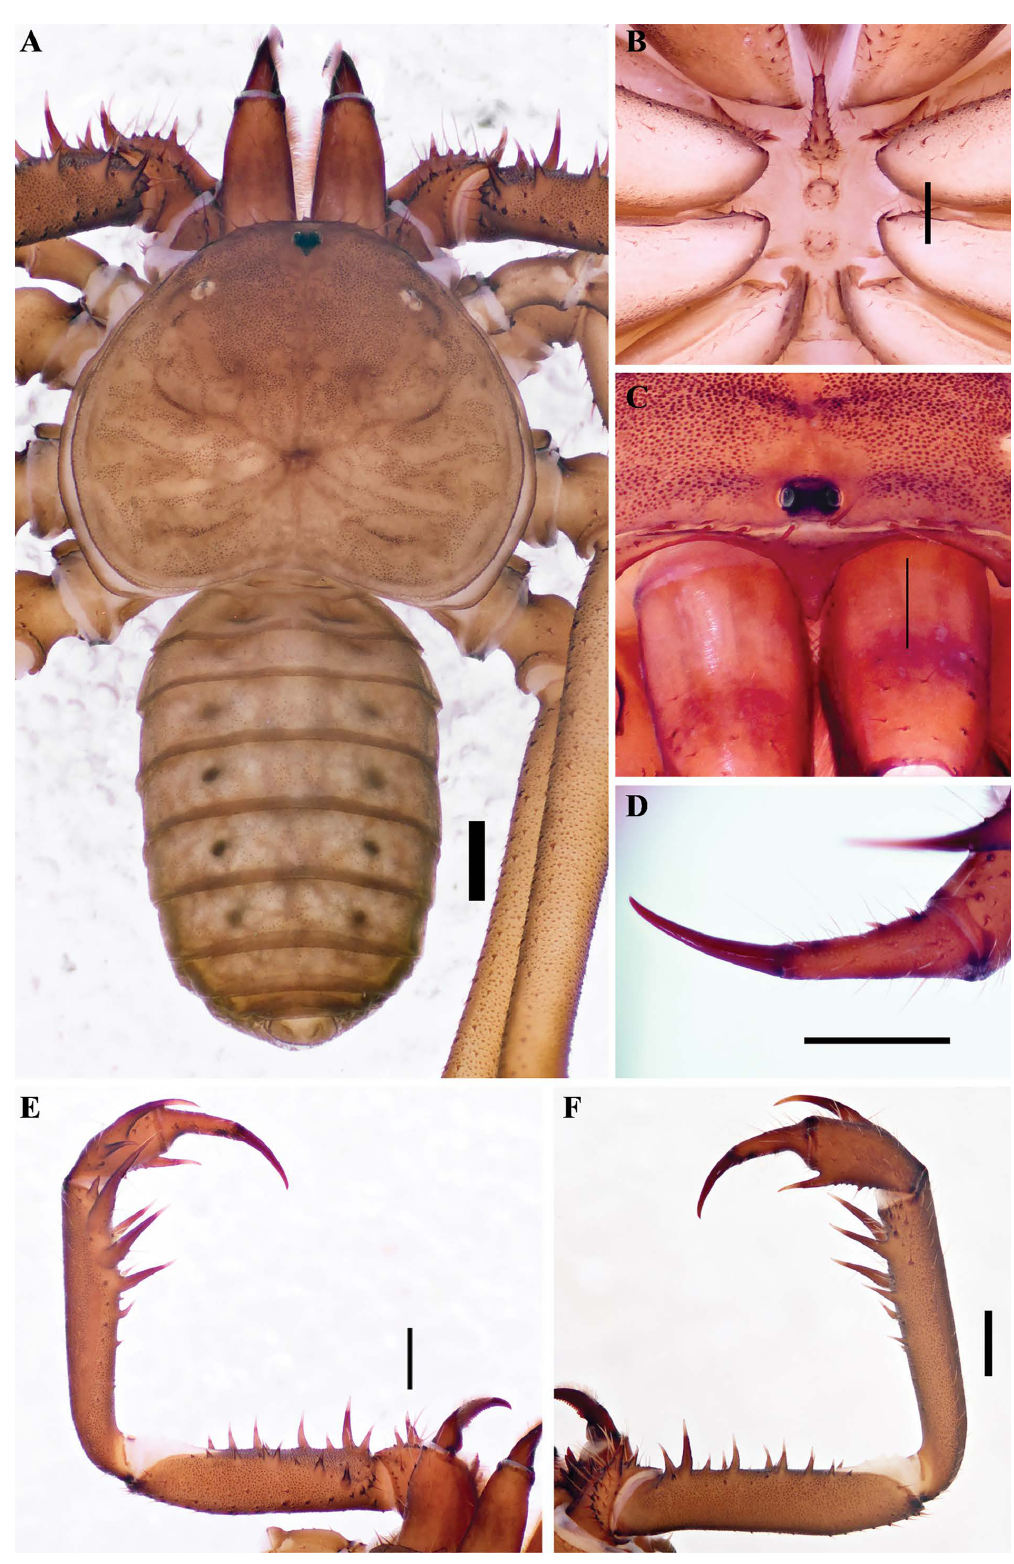
Fig. 47. Charinus apiaca sp. nov. (MNRJ 9286), general morphology, ♀. A . Habitus, dorsal view. B . Sternum, ventral view. C . Frontal process. D . Pedipalp tarsus, frontal view. E . Pedipalp, dorsal view. F . Pedipalp, ventral view. Scale bars: A, D–F = 1 mm; B–C =